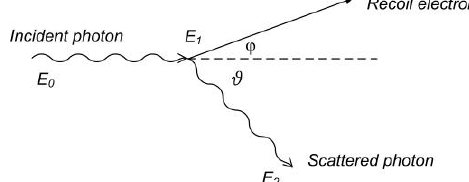
Fig. 2. Compton scattering of a gamma-ray photon and a recoil electron. The incident photon energy E 0 , the electron energy E 1, and the angle ϑ dependence are defined by (1), scattered photon energy E 2 is not relevant.